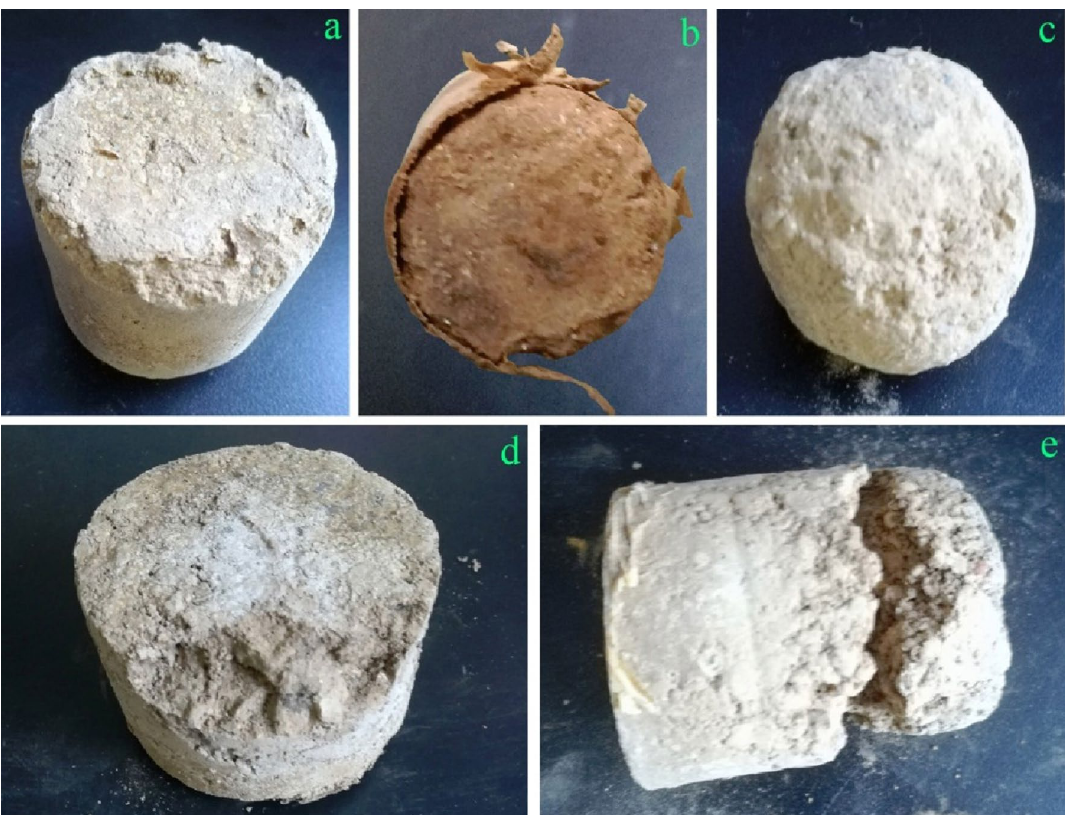
Figure 8. Typical soil column samples a-e of vertical vibration